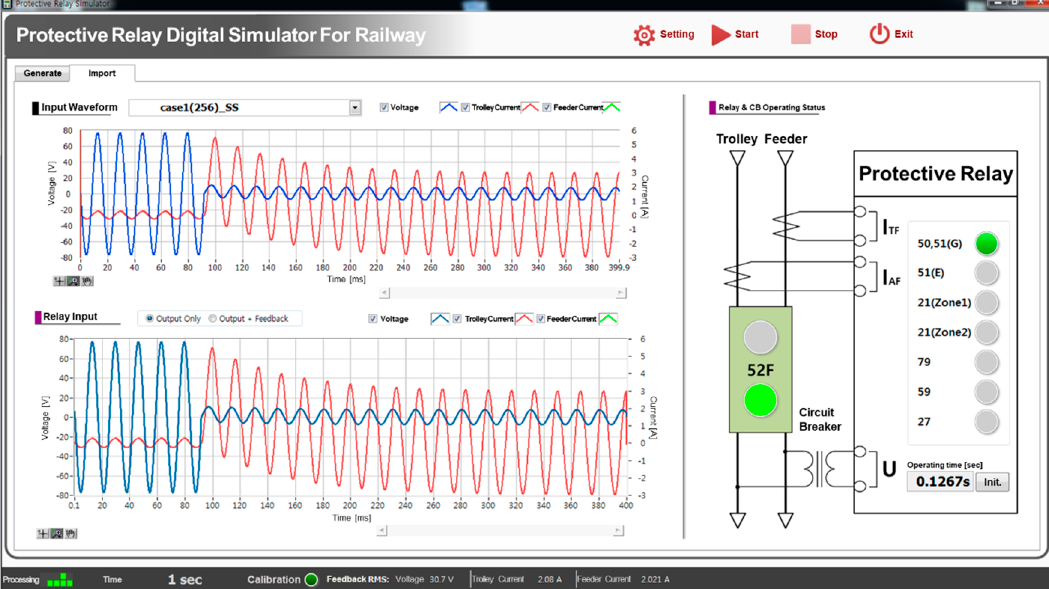
Figure 15. Simulation results in the digital simulator interface.